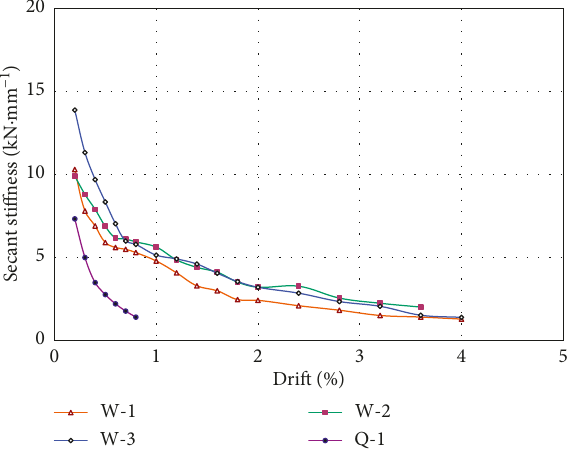
Figure 14: Energy